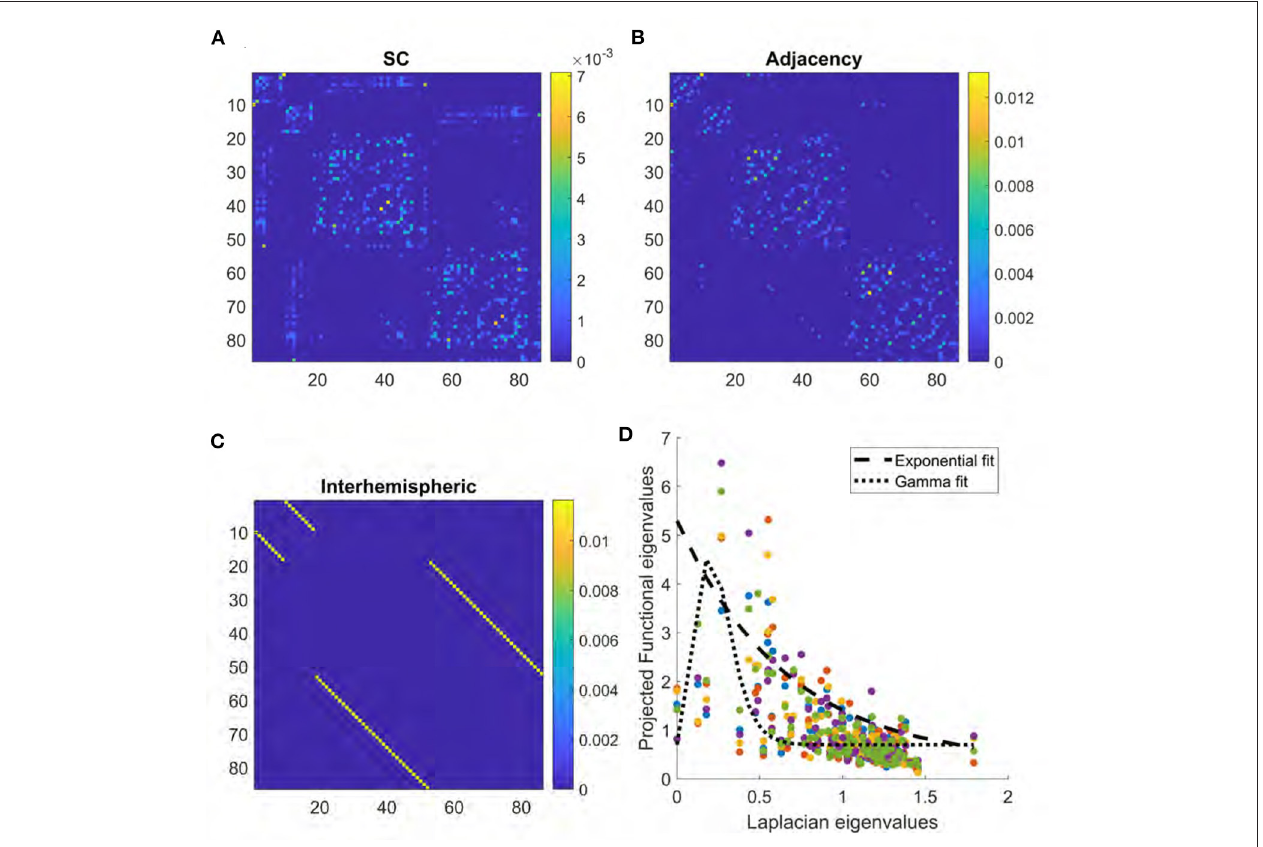
FIGURE 1 | (A) Structural connectome derived from DTI. (B) Adjacency matrix derived from the surface area of boundary between regions in brain atlas. (C) Interhemispheric matrix representing connections between left and right homologous brain structures. (D) Scatter plot of relationship between Laplacian eigenvalues and the projections onto FC given by UFU H . Colors represent data from each of five different subjects. Dashed line provides an example of exponential fitting, while dotted line represents gamma